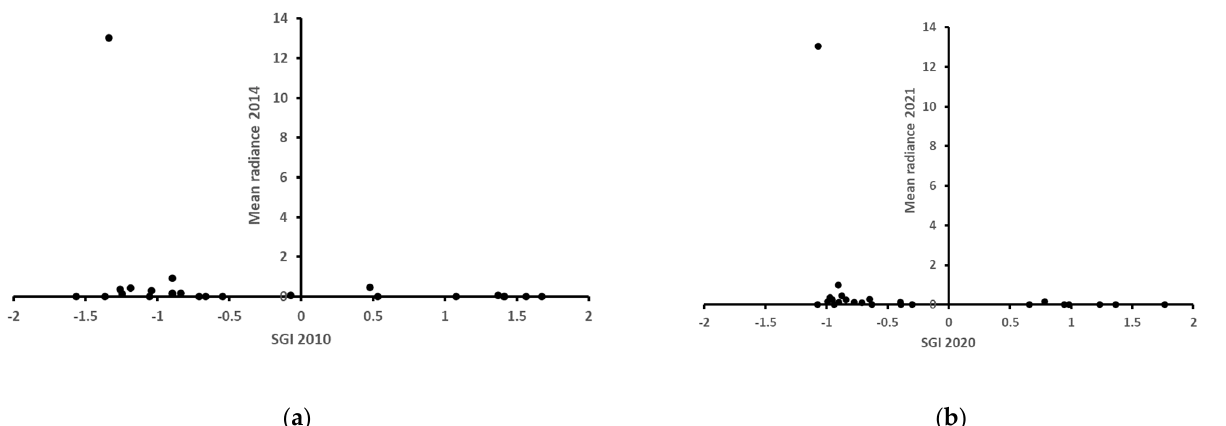
Figure 7. VIIRS average radiance in 2014 and 2021 and SGI from 2010 and 2020.